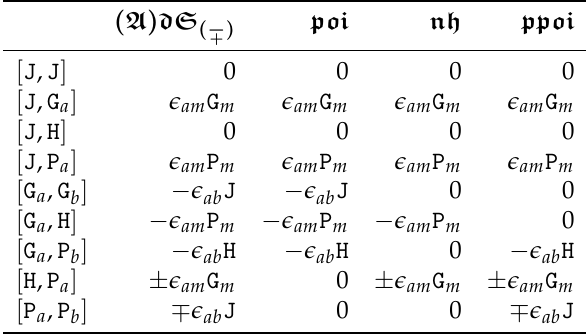
Table A1. (Anti-)de Sitter, Poincaré, Newton–Hooke and para-Poincaré algebras. The upper sign is for AdS (and contractions thereof) and the lower sign for dS (and contractions thereof).